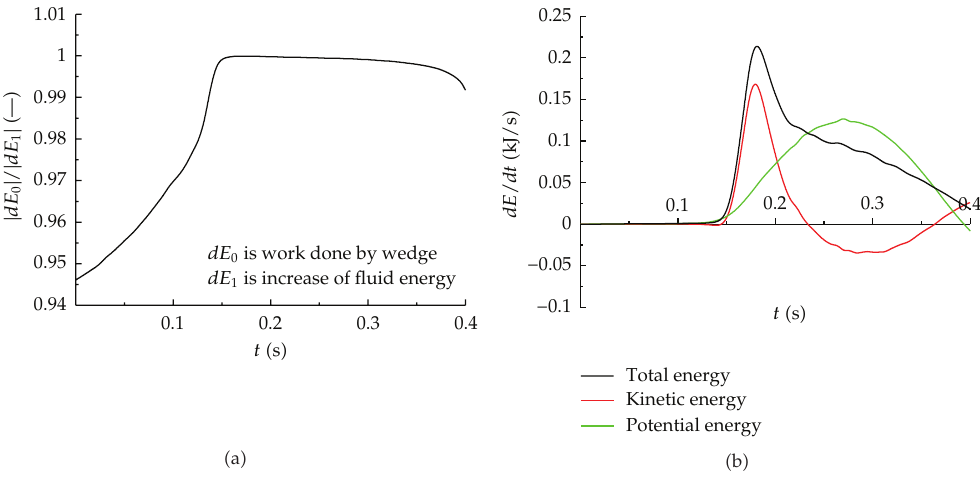
Figure 8: Time histories versus ratio (cid:2) a (cid:3) and rate (cid:2) b (cid:3) of energy variation in fluid field during the initial water-entry